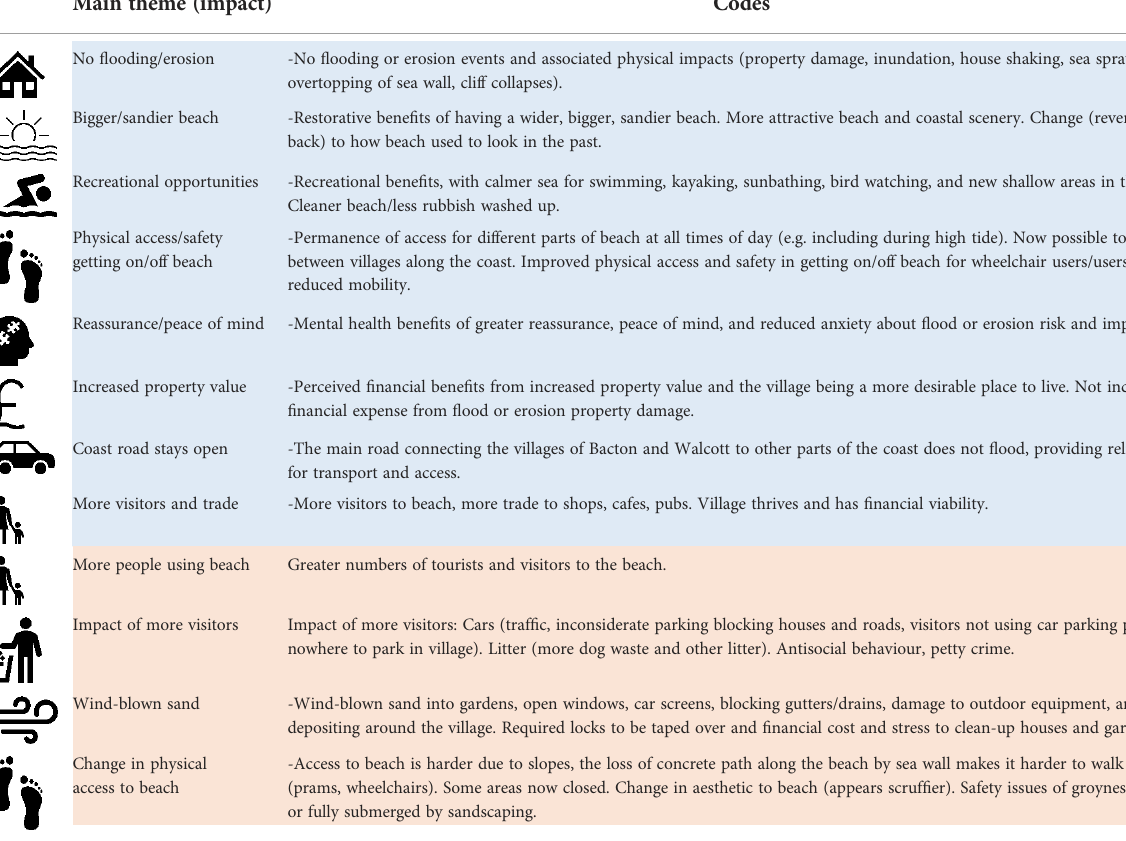
TABLE 2 Reported positive and negative impacts of the sandscaping scheme from residents. Main theme